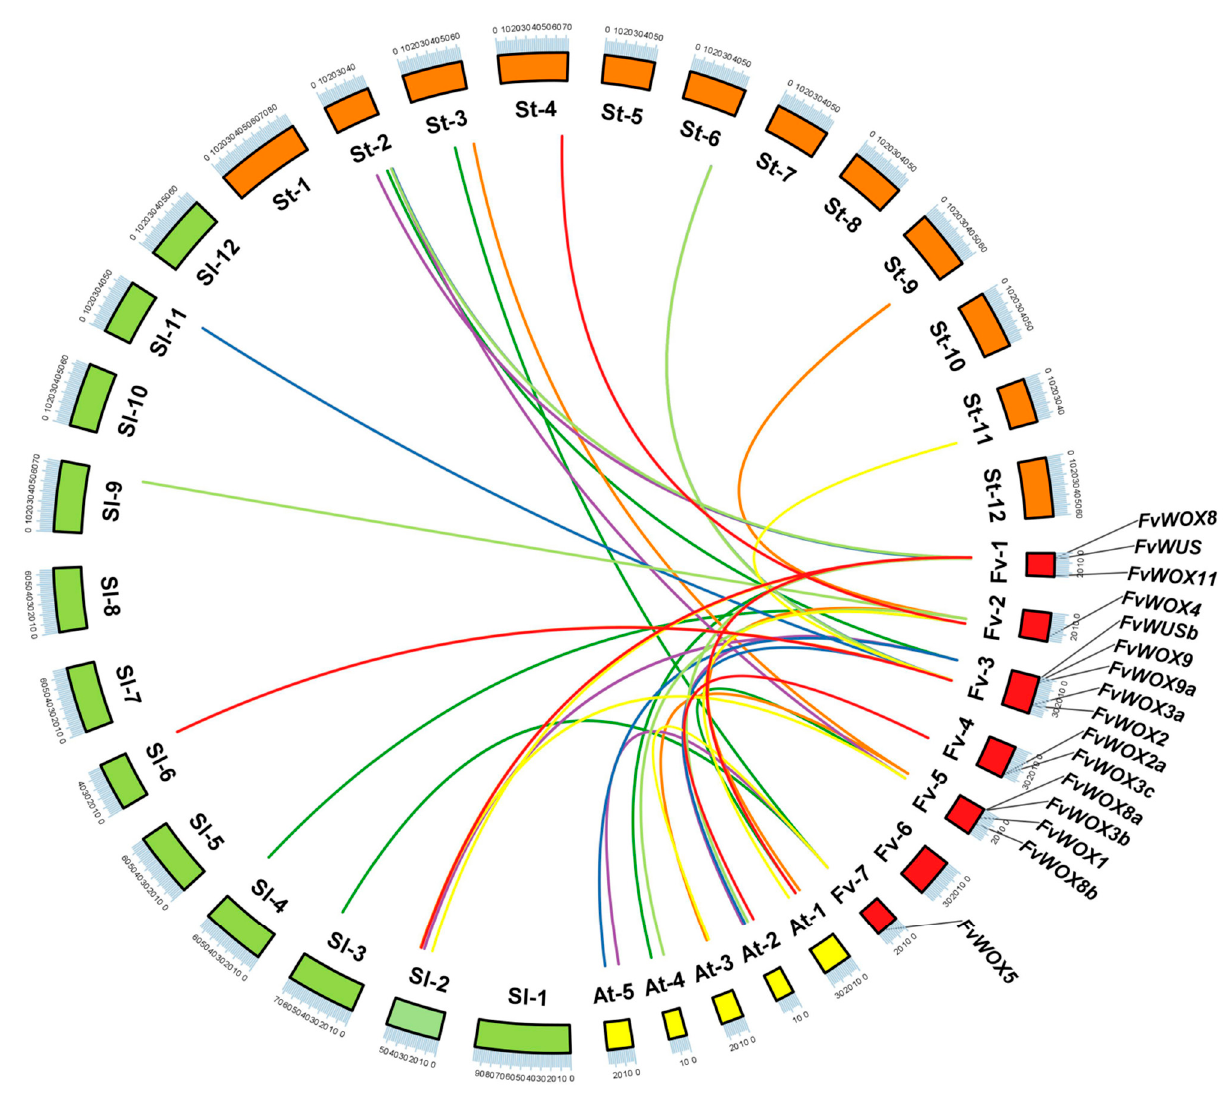
Figure 4. Synteny analysis of WOX genes between Fragaria vesca and three representative plant species. Genes connected by lines are homologous genes. Fv-1 to Fv-7: the chromosomes of Fragaria vesca . At-1 to At-5: the 5 chromosomes of Arabidopsis , Sl-1 to Sl-12: the 12 chromosomes of Solanum lycopersicum , St-1 to St-12: the 12 chromosomes of Solanum tuberosum .